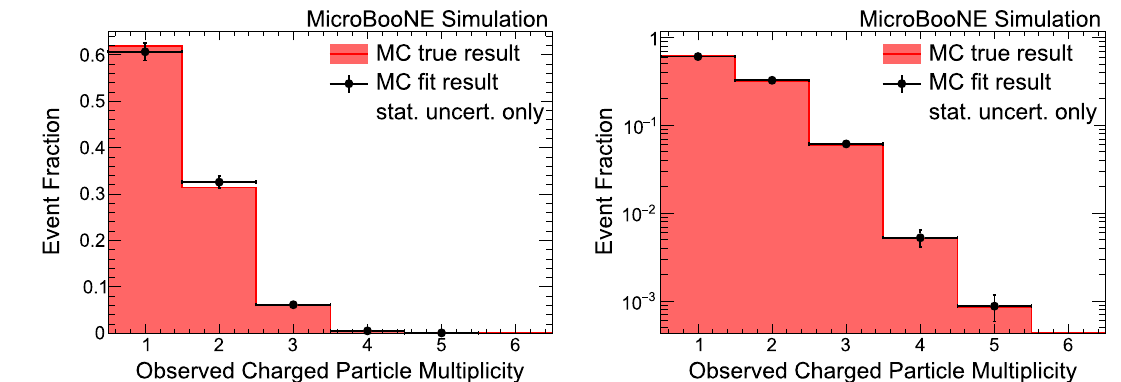
Fig. 8 Overlaid true and fitted observed neutrino multiplicity distributions from the MC default sample in linear scale (left) and in log y scale (right)